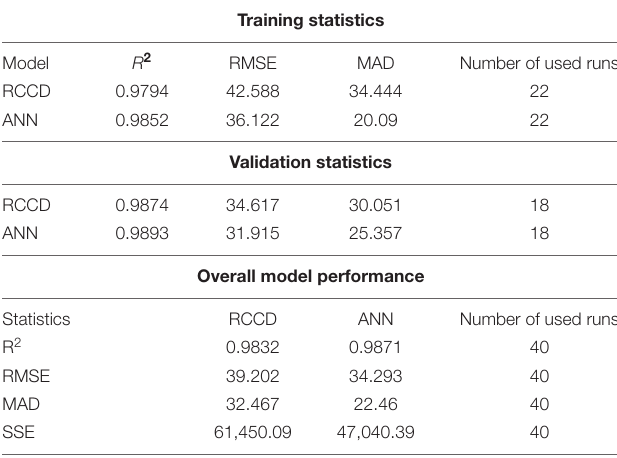
TABLE 4 | Statistics of the model performance created by RCCD and ANN.